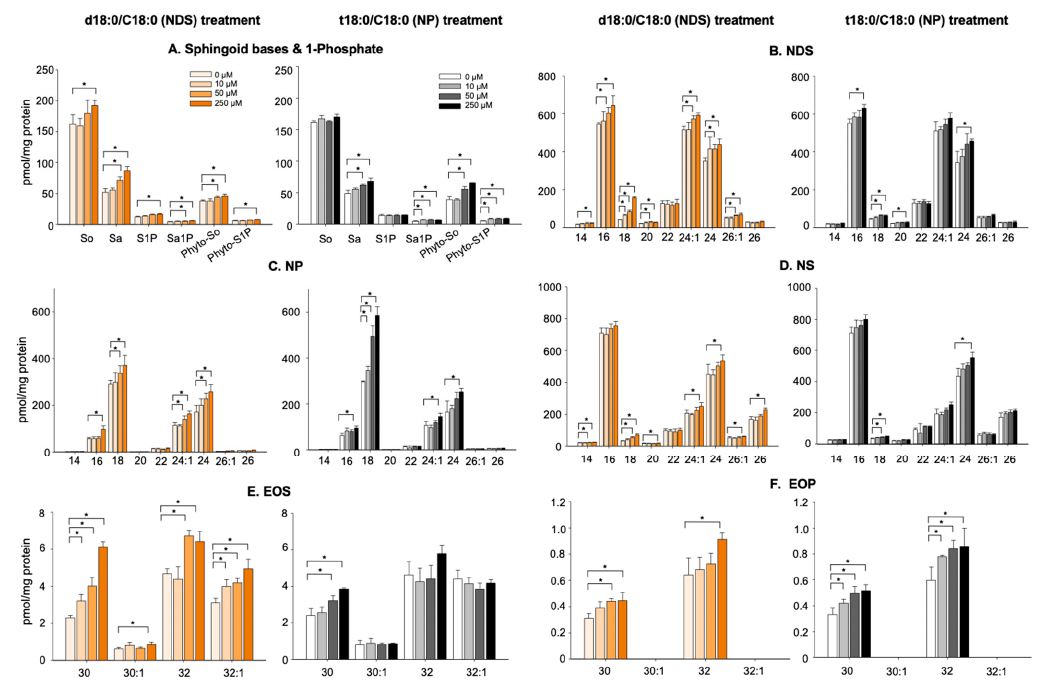
Figure 3. Exogenous Cer further increases Cer levels in late stage of differentiated KC . Cer species containing ß-hydroxy FA, 6-hydroxy sphingosine (H), 4,14-sphingadiene (SD), and omega-hydroxy Cer were not analyzed. n = 3, Mean ± SD. * p < 0.01 vs indicated group. see details in Materials and Methods.